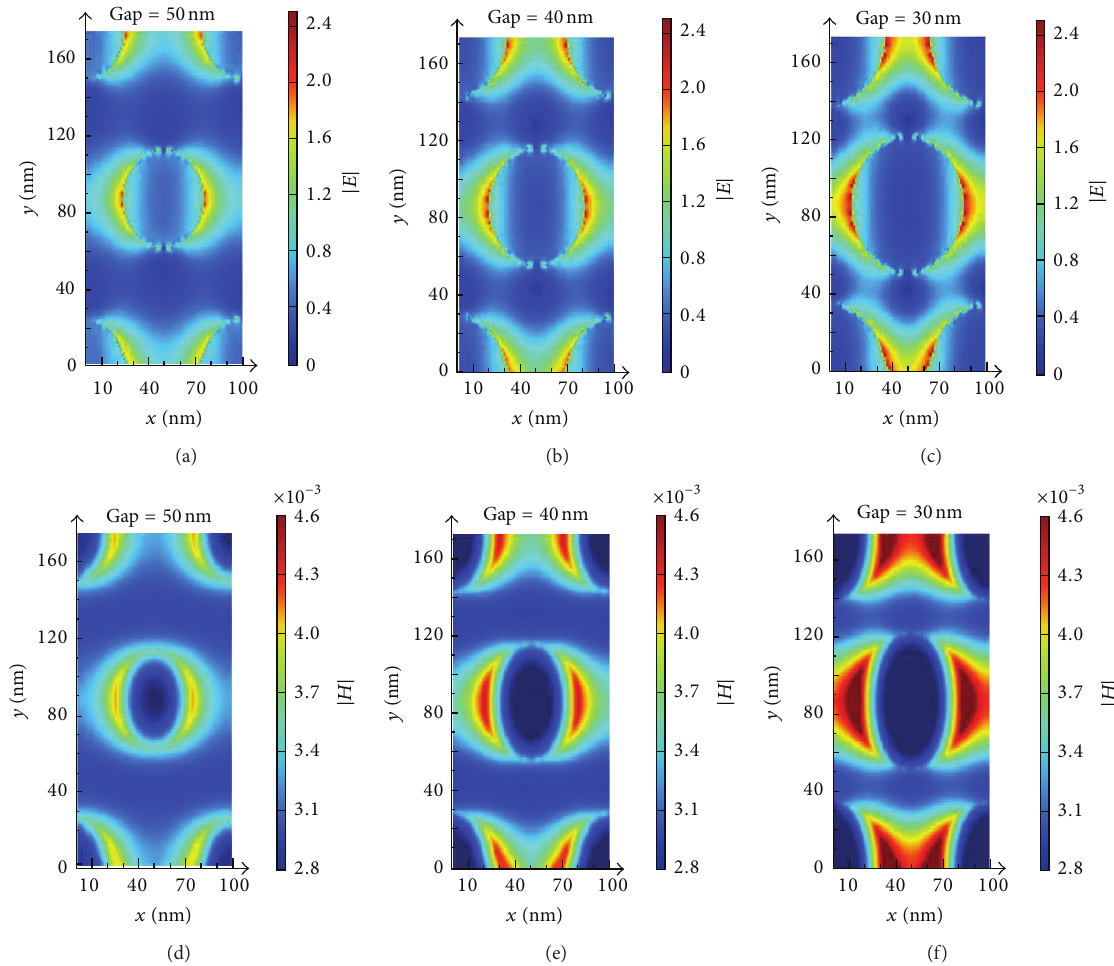
Figure 6: (a), (b), and (c) ((d), (e), and (f)) are the electric (magnetic) field distributions of the 𝑥 - 𝑦 plane for different gap sizes.